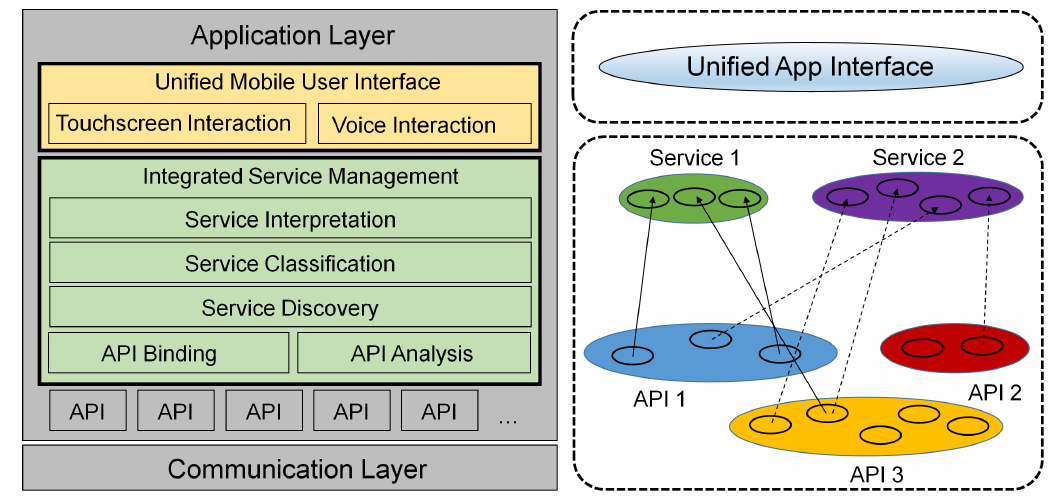
Figure 2. MIUI architecture: software stack ( left ) and service mashup ( right